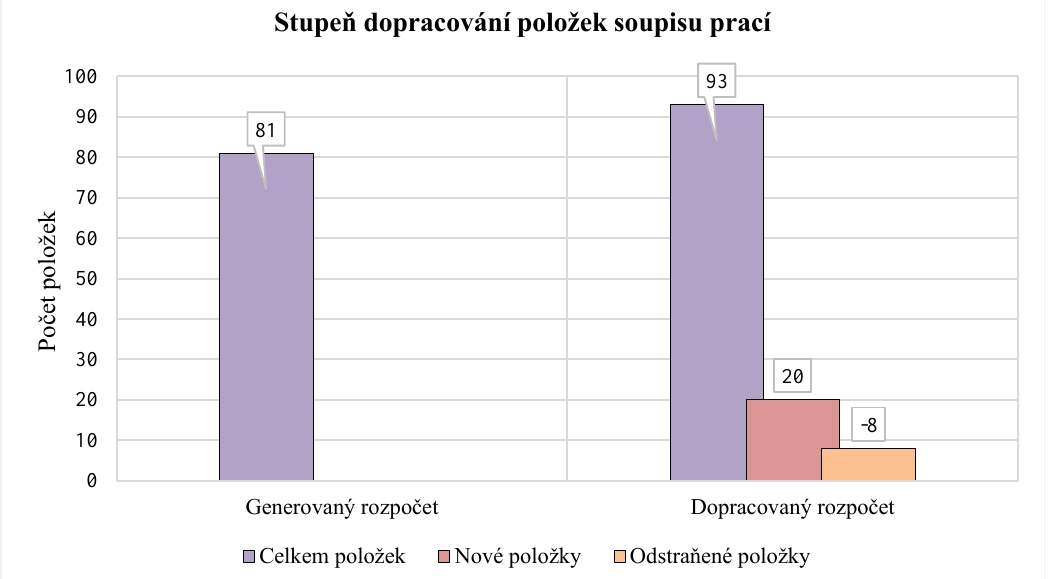
Graf 1: Stupeň dopracovanosti položek soupisu prací (zdroj: ČERNOVICKÝ, Vojtěch. Bakalářská práce. V Praze: ČVUT, 2020, str. 96)